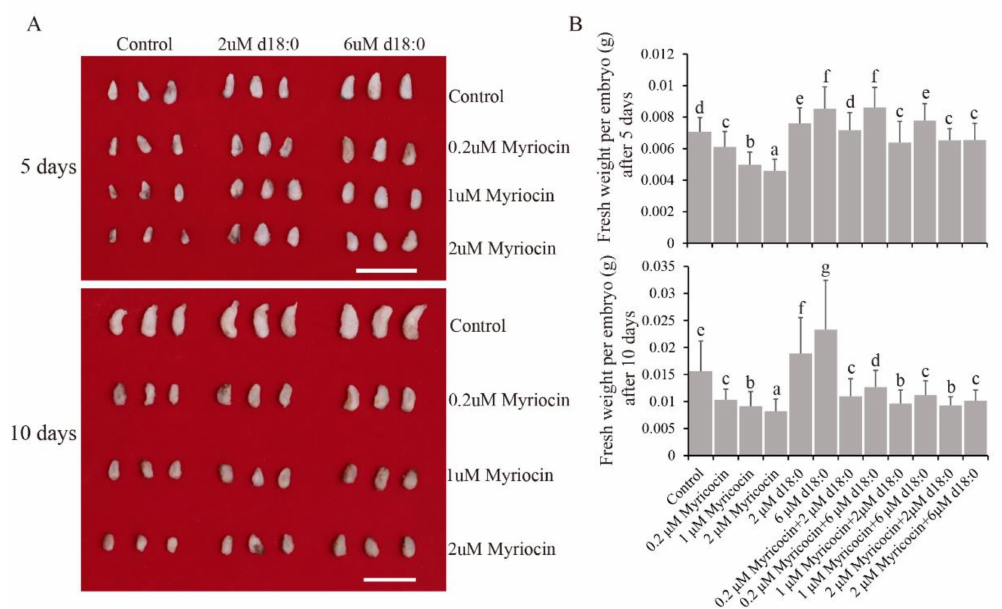
Figure 3. DHS (d18:0 dihydrosphingosine) partially restored the inhibitory effect of myriocin on embryo fresh weight. ( A ) Phenotypic characteristics of myriocin- and DHS-treated embryos after 5 and 10 days of in vitro culture at different concentrations. Scale bars = 1 cm. ( B ) Fresh weight of myriocin- and DHS-treated embryos after 5 days (upper panel) and 10 days (lower panel) at different concentrations. Values represent means ± SD ( n = 24). Different letters above the bars indicate significant differences at the p = 0.05